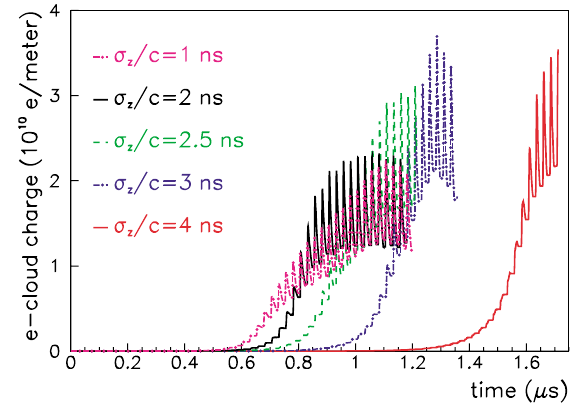
FIG. 3. (Color) Electron cloud buildup in a PS combined func- tion magnet during the first 1 : 7 (cid:16) s of the bunch train for different bunch lengths with elastic reflection of the electrons.